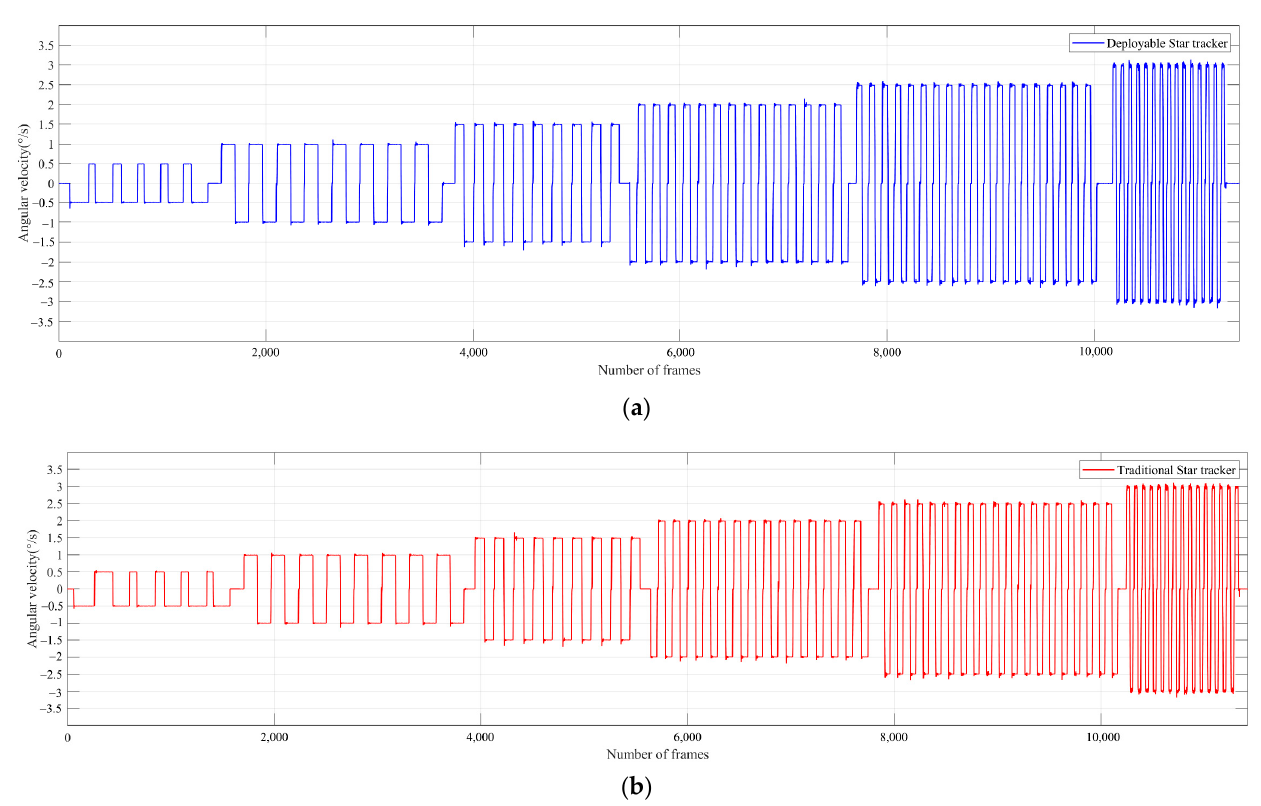
Figure 19. ( a ) Measured angular velocity of the DST. ( b ) Measured angular velocity of the TST. Table 7. The average accuracy ( 3σ ) for DST and TST under slew rate of 0.5, 1.0, 1.5, 2.0, 2.5 and 3.0°/s.